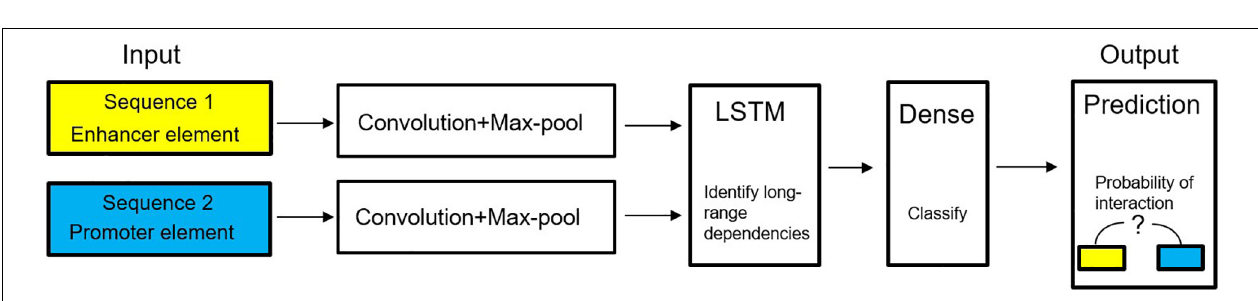
networks to extract patient information patterns. Rajkomar et